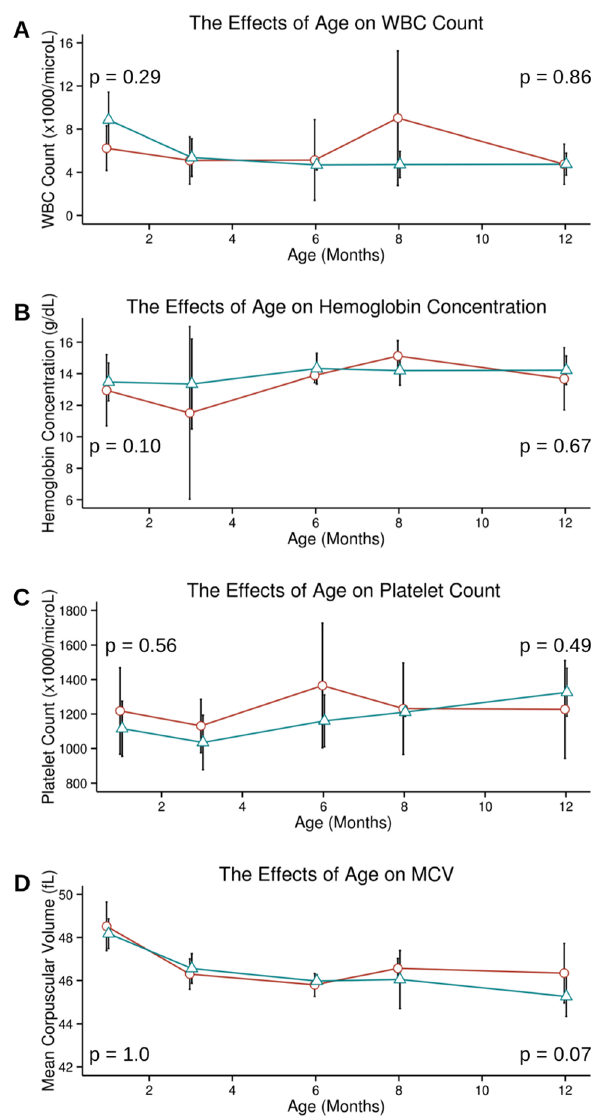
Figure 3. The effects of age on blood cell indices. C57BL/6J mice were mated with mice harboring a heterozygous knockout of MIWI2. Blood indices from homozygous knockout progeny (red circles) are compared with wild type progeny (blue triangles) at 1, 3, 6, 8 and 12 months of life. The blood cell indices include [A] white blood cell count, [B] hemoglobin concentration, [C] platelet count, and [D] mean corpuscular volume. P-values are given for the 1 month and 12 month time